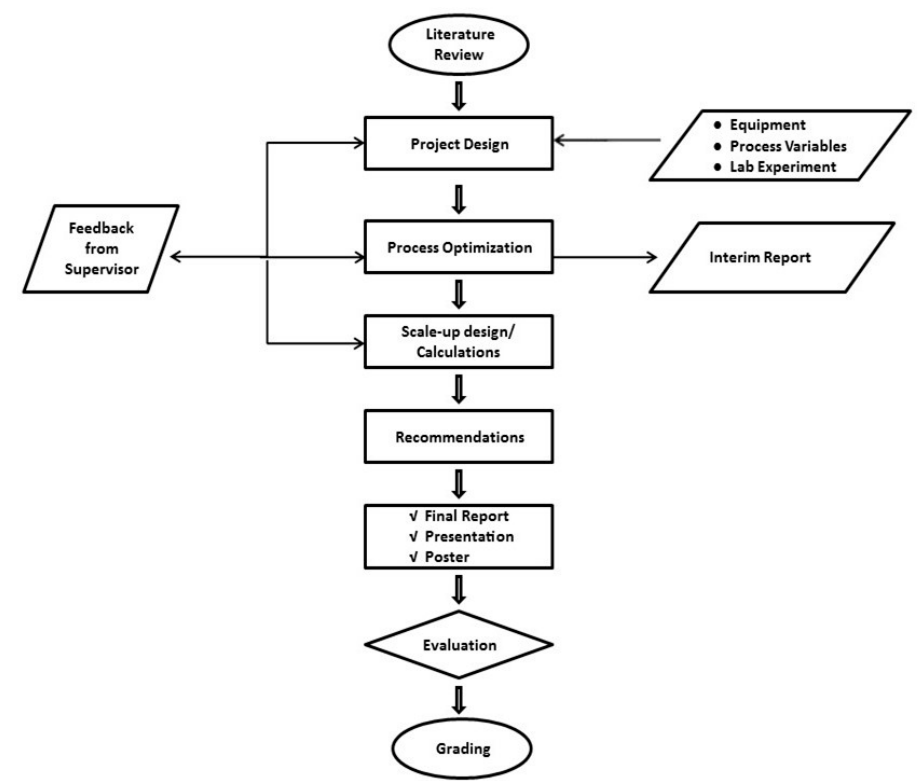
Figure 2. Diagram showing the overall methodology of the process execution. Figure 2. diagram showing the overall methodology of the process execution.